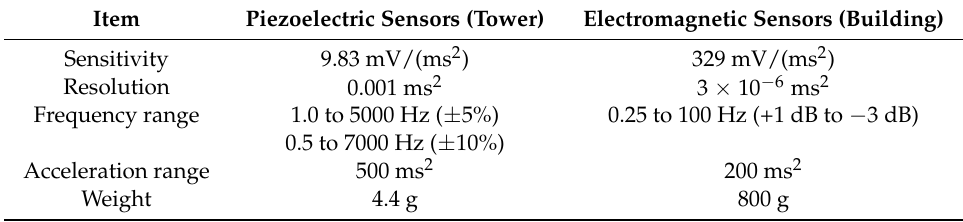
Table 1. Details of accelerometers used for building and tower